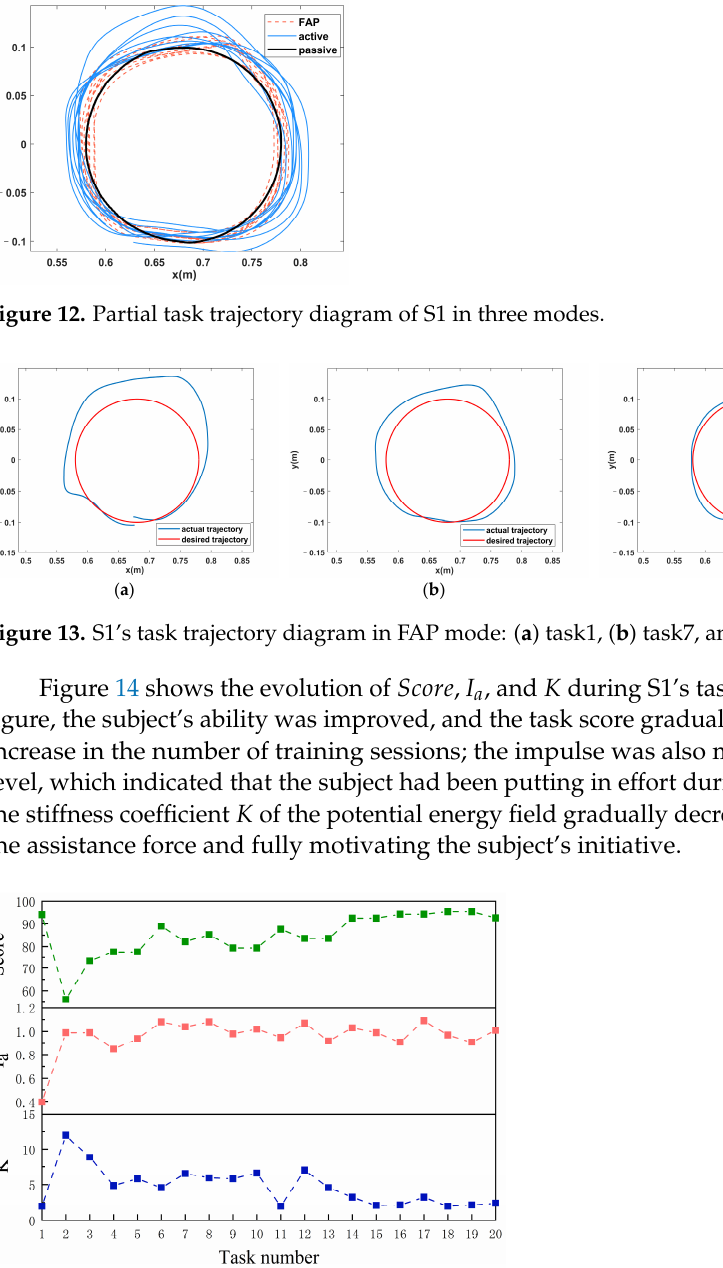
Figure 14. Evolution of 𝑆𝑐𝑜𝑟𝑒,𝐼 (cid:3028) , and 𝐾 during S1’s task in FAP mode.